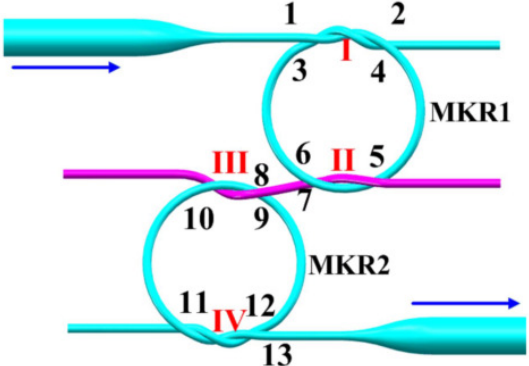
Figure 11. Configuration of cascaded microfiber knot resonators [71]. Reprinted with permission from Ref. [71] ©The Optical Society.